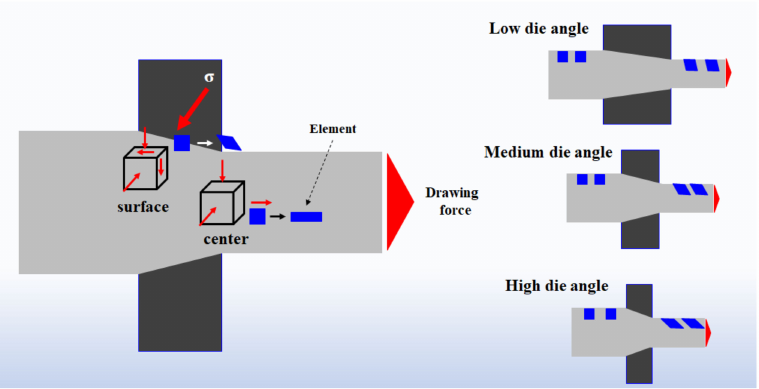
Figure 14. Schematic of redundant work at the surface area of the drawn wire with the die angle.